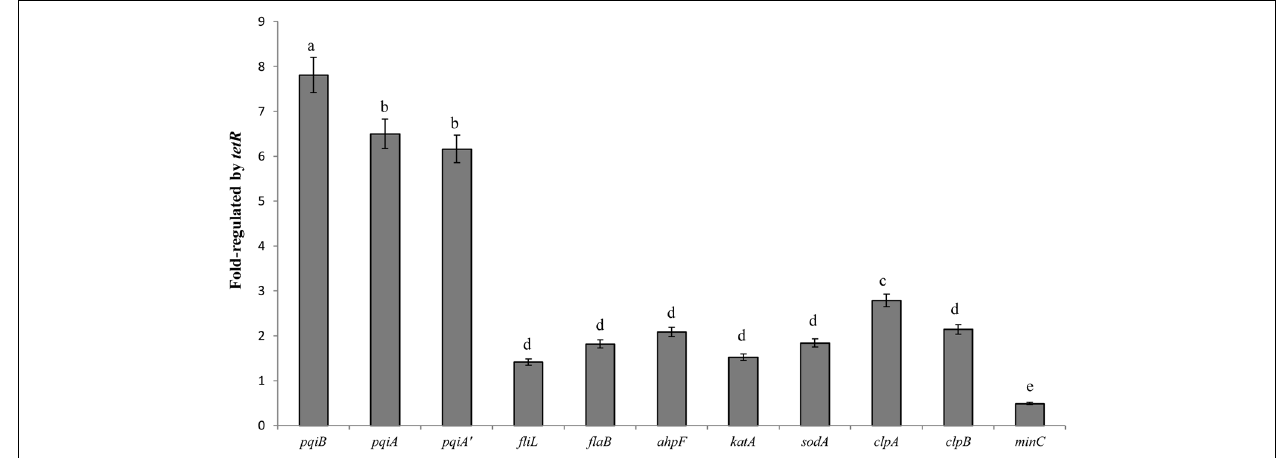
FIGURE 6 | Quantitative PCR analysis shown as fold change in gene expression regulated by tetR . The data were quantified by the change-in-cycling-threshold method (2 − (cid:3)(cid:3) Ct ) using the 16S rRNA for normalization. Total RNA was extracted from RS-1 and RS- tetR